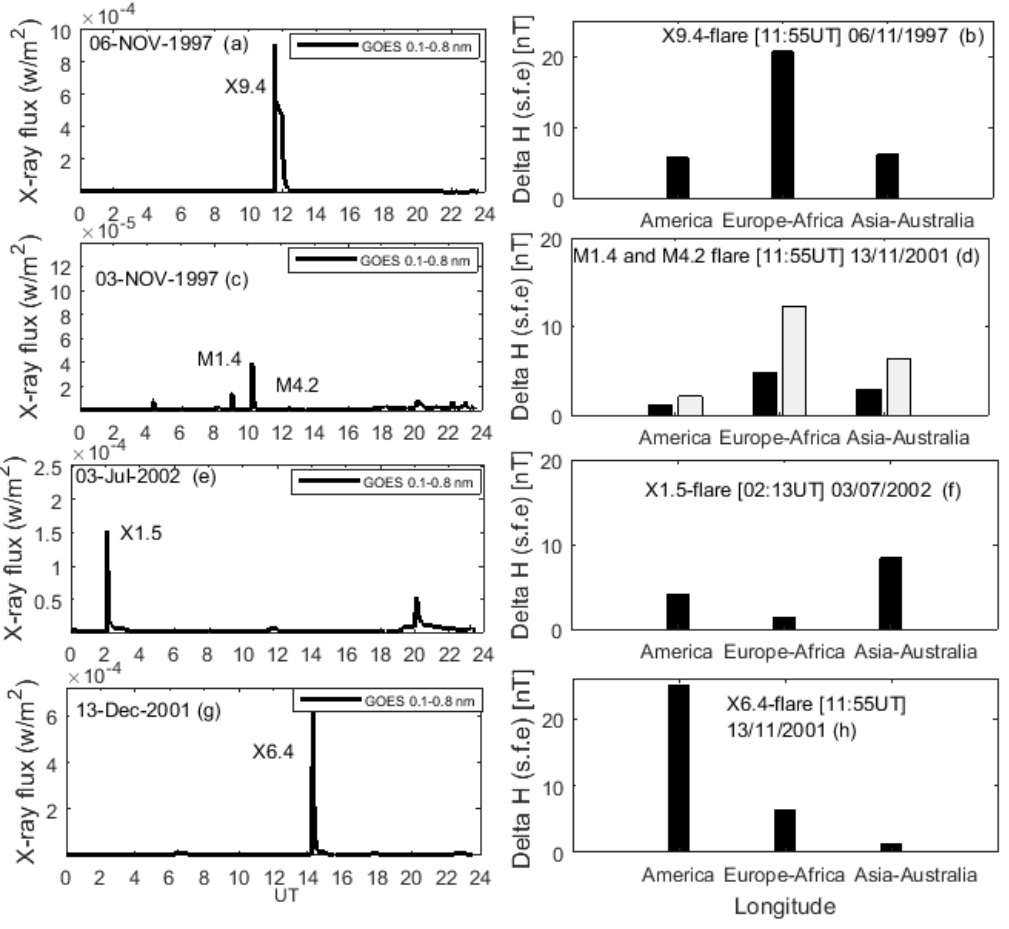
Figure 6. X-ray flux and histograms of the average variations of magnetic crochets in South and North America, Europe-Africa and Asia-Australia longitude sectors for X9.4 solar flare of 6 November 1997, M1.4 and M4.2 solar flares of 3 November 1997, X1.5 solar flare of 3 July 2002, X6.4 solar flare of 13 December 2001, and X1.7 and X2.1 solar flares of 25 October 2013. ( a , b ) show respectively X-ray flux and mean variation of Hsfe for X9.4, ( c , d ) show respectively X-ray flux and mean Hsfe for M1.4 and M4.2, ( e , f ) show respectively X-ray flux and mean Hsfe for X1.5 , then ( g , h ) show respectively X-ray flux and mean Hsfe for X6.4. Table 4. The magnetic response to the solar flare X9.4 of 06/11/1997. Observatory